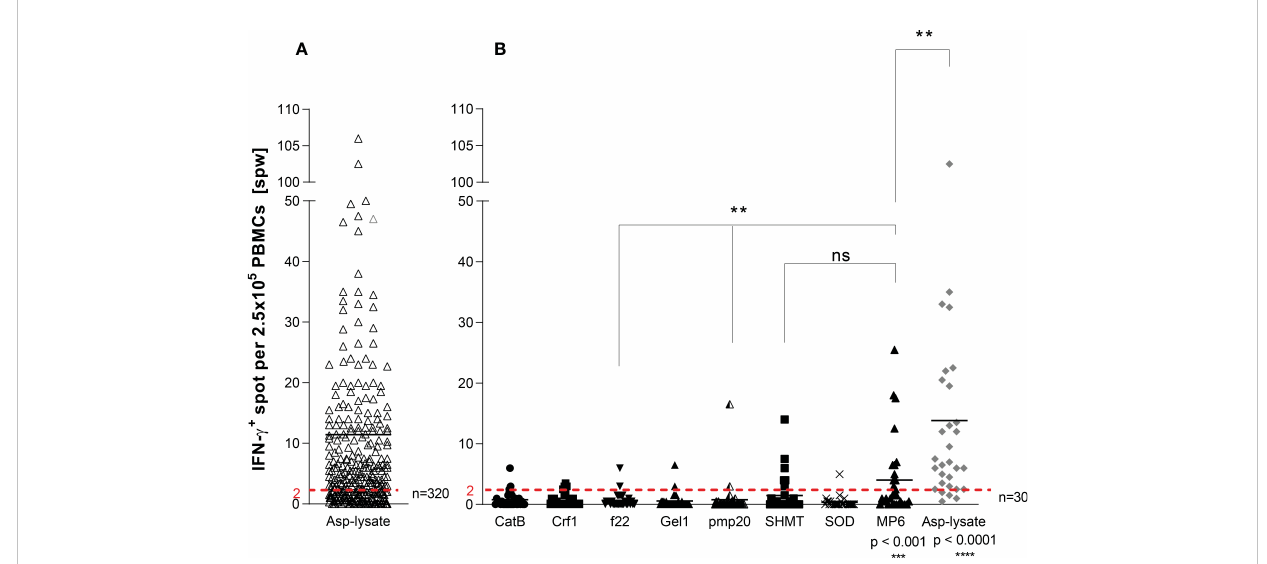
FIGURE 1 Screening for Asp-speci fi c T cells by IFN- g EliSpot. ATC responses elicited by the (A) Aspergillus fumigatus (Asp) lysate alone (n=320) or with (B) Apsp-lysate (n=30/320) and overlapping peptide pools from Aspergillus (CatB, Crf1, f22, Gel1, pmp20, SHMT, SOD) and Candida albicans (MP65) (n=30) were determined by IFN- g EliSpot assays. 2.5 x 10 5 cells/well of isolated PBMCs from healthy donors were stimulated with the investigated peptide pools (1µg per peptide/ml) and the Asp-lysate (50 µg/ml) for 16 hours on anti-IFN- g precoated EliSpot plates. Results are indicated as number of spots per well (spw) after the subtraction of background spots (negative control = unstimulated cells). The cut-off value for a positive antigen-speci fi c T-cell response was de fi ned with ≥ 2 antigen-induced spw. Data are shown in total as individual result and mean. Statistically signi fi cant difference between MP6 or Asp-lysate to the other peptide pools, unless otherwise highlighted, is indicated by (**p < 0.01,***p<0.001 and ****p<0.0001). ns, not signi fi